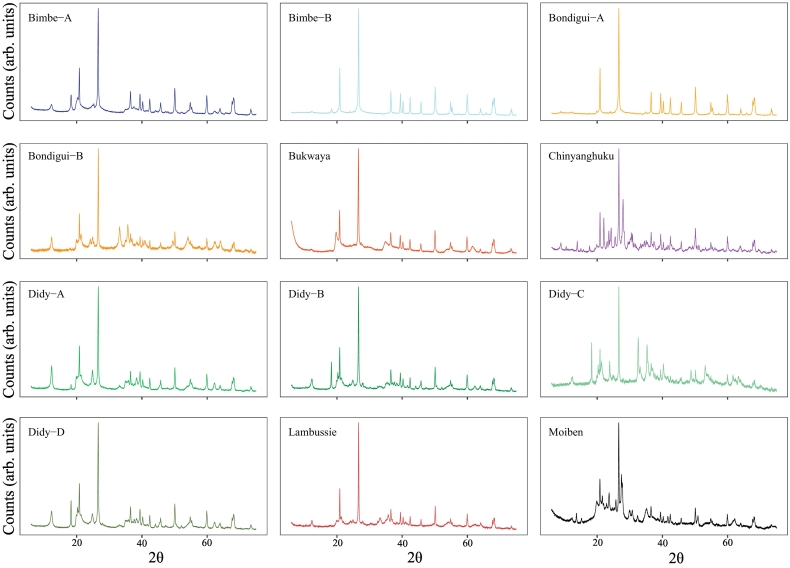
Mean diffractograms of the five replicates for each of the twelve selected soil samples, averaged at each 2θ measurement interval. All count intensities have been square-root transformed in order to lessen the intensity of the quartz peaks relative to the remaining mineralogy, and hence aid with comparison.